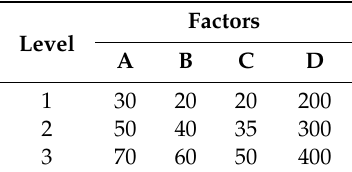
Table 2. L 9 (3 4 ) orthogonal factors and levels of extraction.